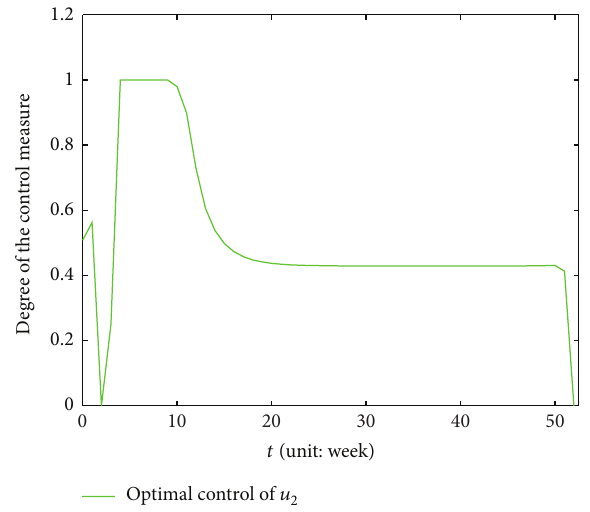
Figure 10: Figures of the optimal control 𝑢 2 when we choose the weight in objective function are 𝑐 1 = 10 2 ; 𝑐 2 = 10 4 .